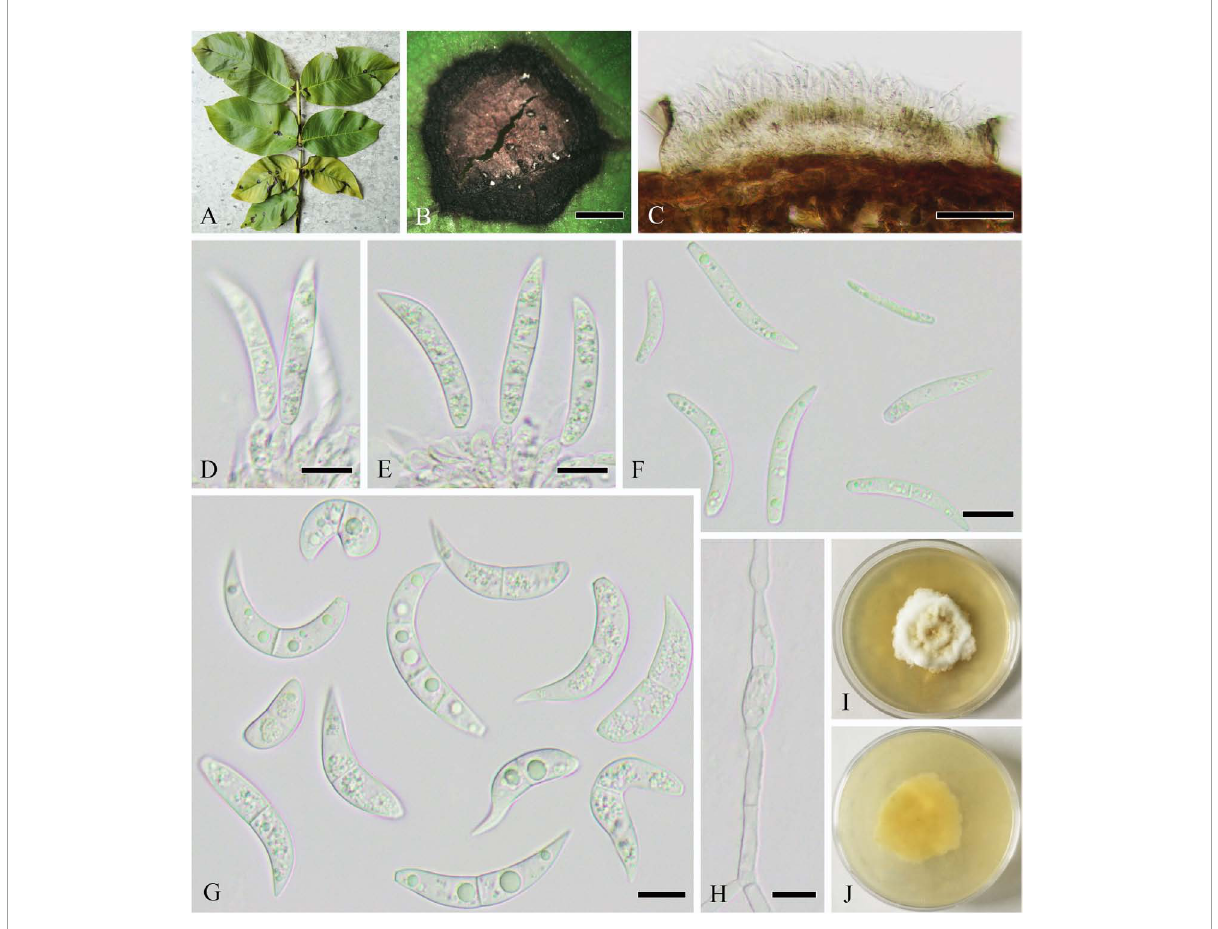
FIGURE8 Ophiognomonia leptostyla (SICAU 22-0102). (A,B) Symptoms of leaf spots observed on host. (C–E) Conidiophores, conidiogenous cells, and developing conidia. (F) Microconidia. (G) Macroconidia. (H) Germinating conidium. (I,J) Colonies on PDA for 25 days. Scale bars: (B) 1,000 µ m, (C) 50 µ m, and (D–H) 10 µ